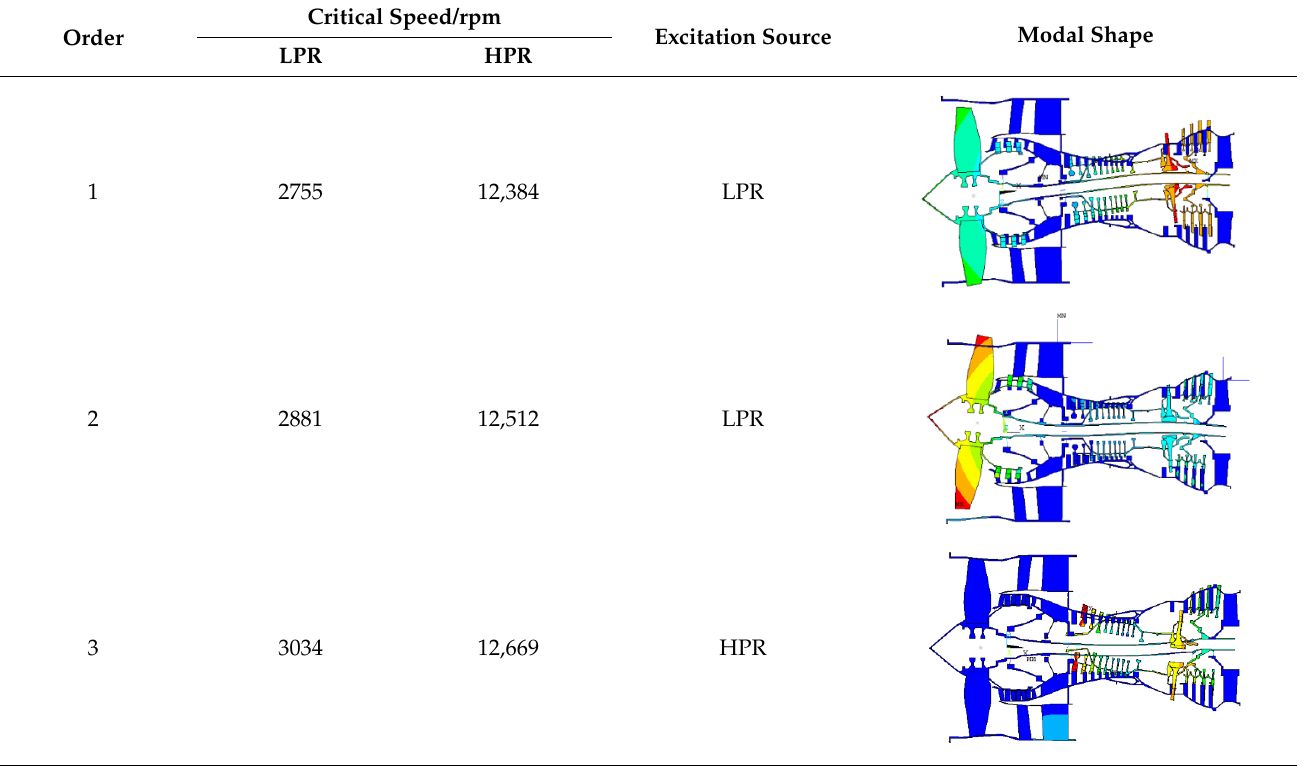
Figure 7. Campbell diagram of low-pressure rotor excitation (FP: forward precession, RP: reverse precession). Figure 8. Campbell diagram of high-pressure rotor excitation (FP: forward precession). The high- and low-pressure rotor speed and modal mode shape corresponding to each critical speed are shown in Table 3. Table 3. The critical speed and mode shape of the whole engine.